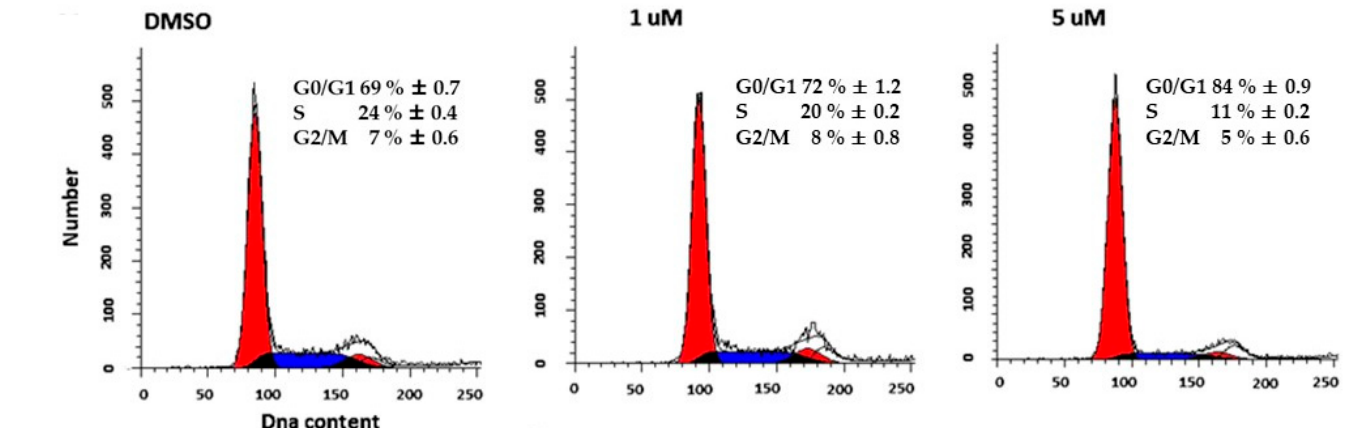
Figure 4. Flow cytometry analysis of the cell cycle. Representative data showed cell cycle distribu- tion with PI staining followed by flow cytometry analysis of HT29 cells treated whit 1 or 5 μ M of 5 for 24 h.